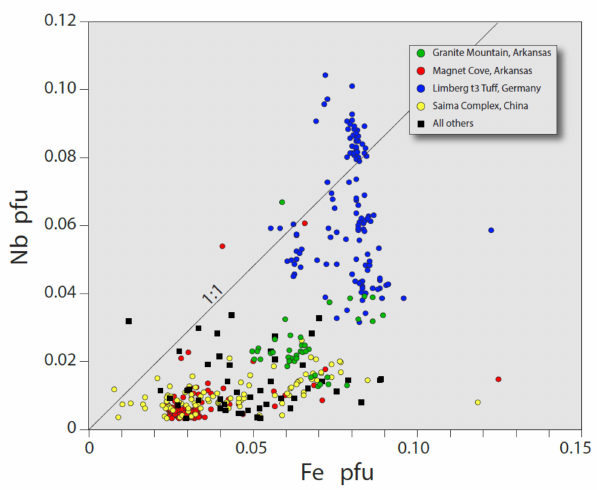
Figure 33. Fe versus LREE + Y in titanite from silica undersaturated rocks and metamorphic rocks. The correlation coefficient (r) and number of analyses (n) are shown.